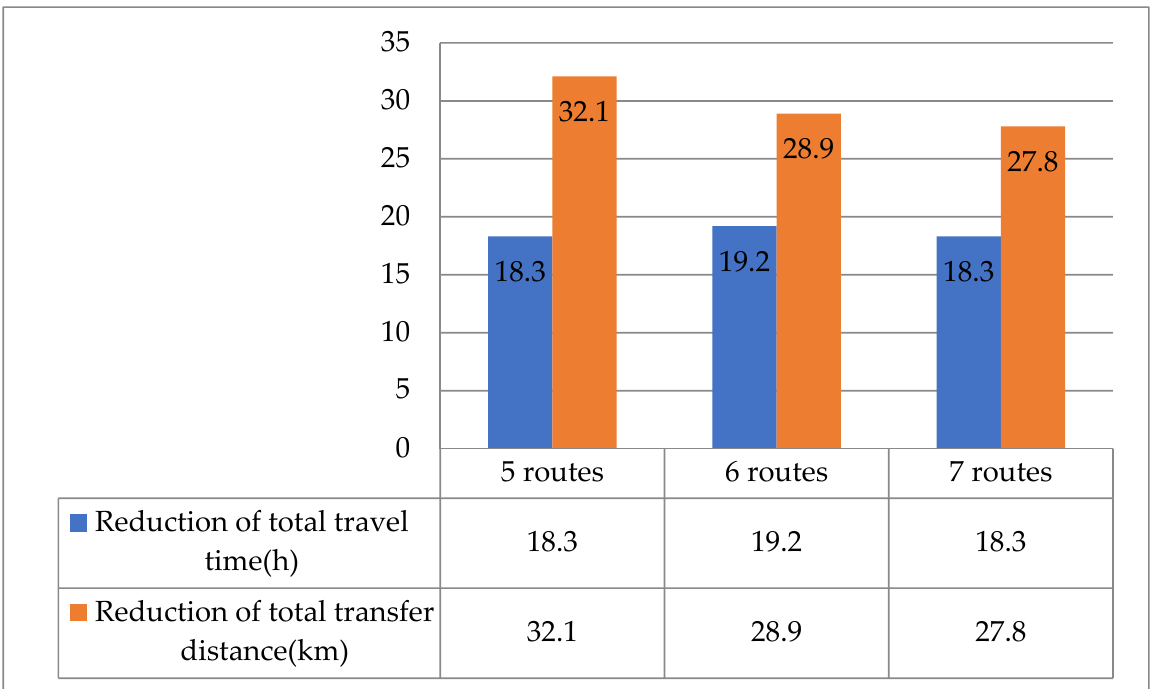
Figure 9. Comparative analysis of the conventional and proposed models for various numbers of routes.